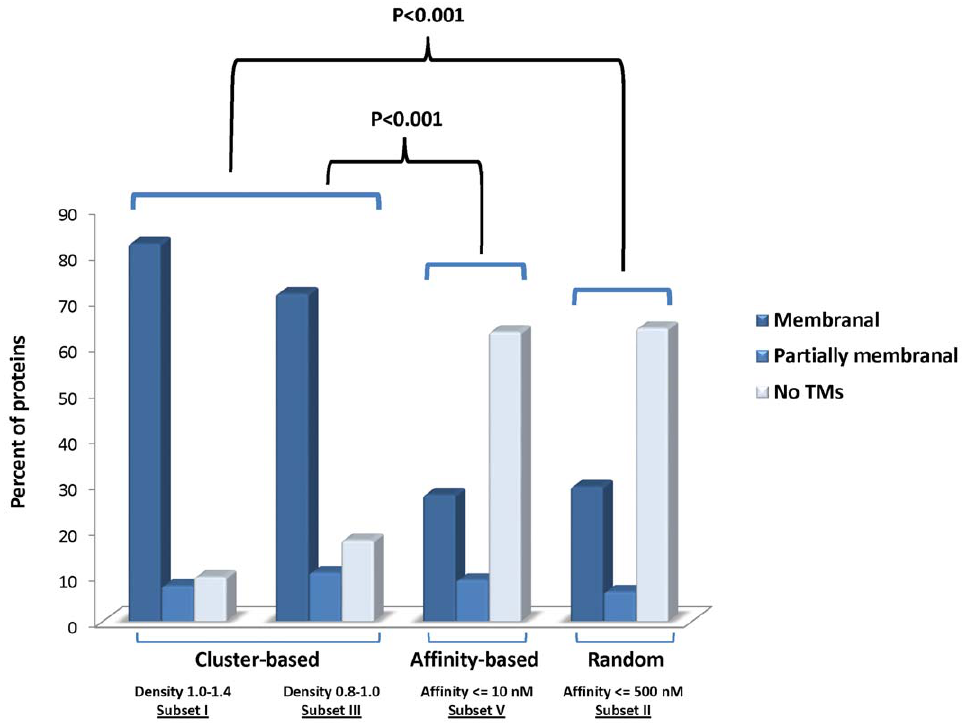
Figure 4. Distribution of parental proteins containing responders according to their membrane topology. Parental proteins containing responder peptides identified by the cluster-based, high affinity-based and random-based approaches are classified as follows: Membrane-spanning proteins (with 10 or more predicted transmembranal domains (TM) and/or TMs spanning at least a third of the protein) in dark blue; partially membranal proteins (less than 10 predicted TMs) in blue; proteins with no predicted transmembranal domains (except signal peptide) in light blue. . P-values are provided for evaluation of significance of difference between membranal proteins in the cluster-based Subsets I and III versus Subset V and versus Subset II.